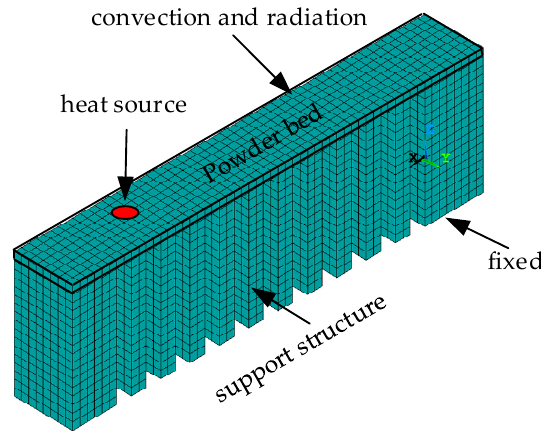
Figure 6. The FEM model and boundary conditions.